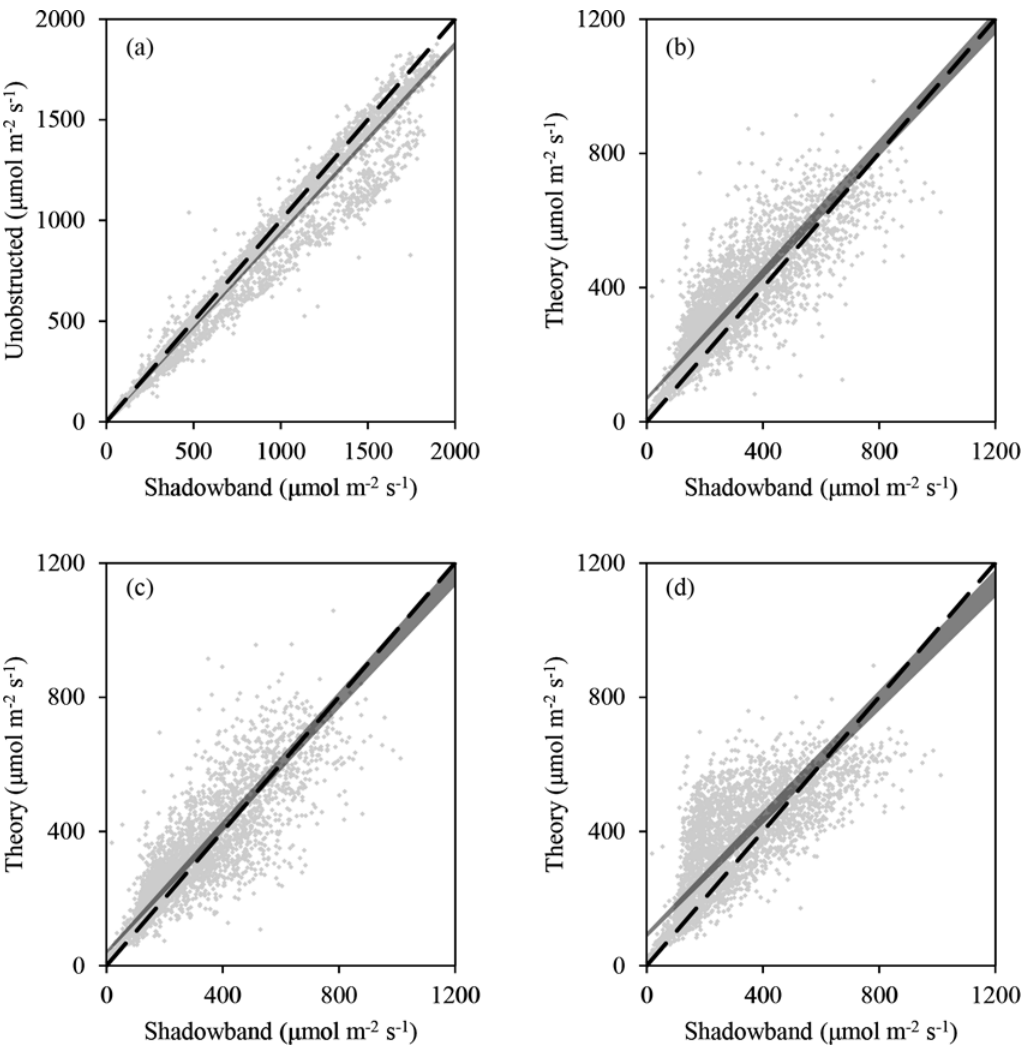
Figure 4. Scatter plots comparing PAR values measured by shadowband system with other accepted methods of quantifying PAR. Dashed line represents ideal one-to-one relationship and grey wedge represents the 95% confidence interval computed using Deming regressions. a) PAR T vs.